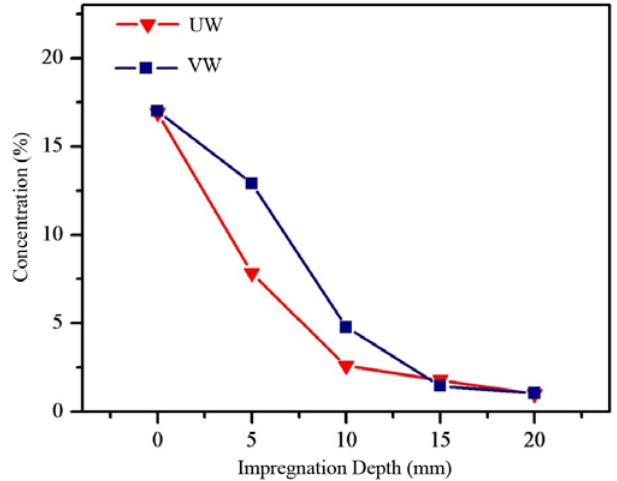
Figure 4. Longitudinal distribution of nano ‐ Ag/TiO 2 wood ‐ based composite materials.